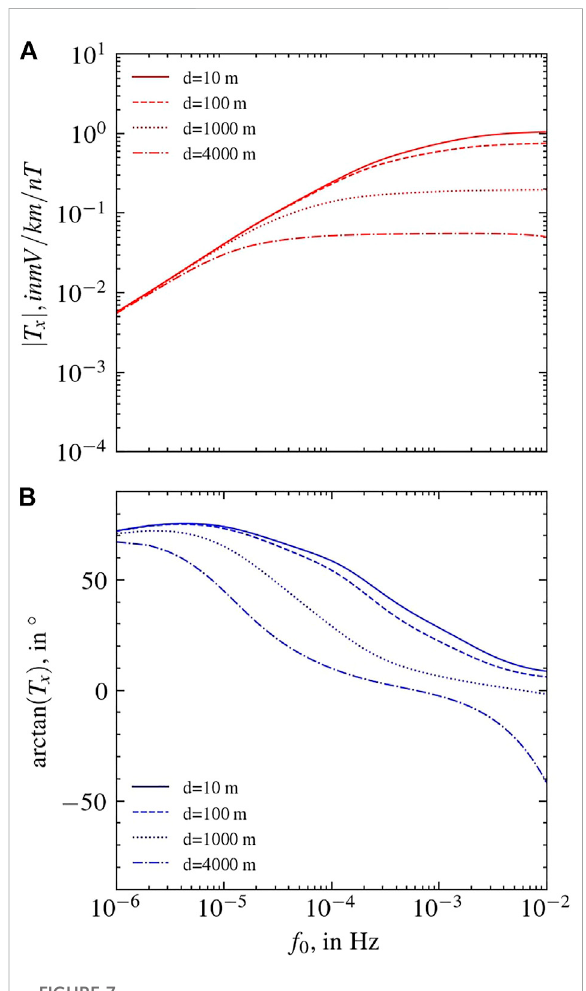
FIGURE 7 (A) Amplitude and (B) phase of the transfer functions T x